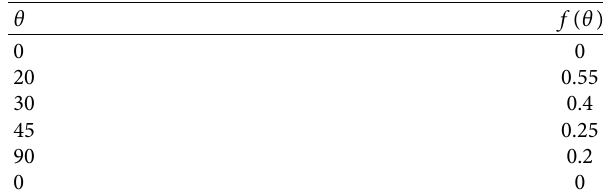
Table 1: The intrusion angle